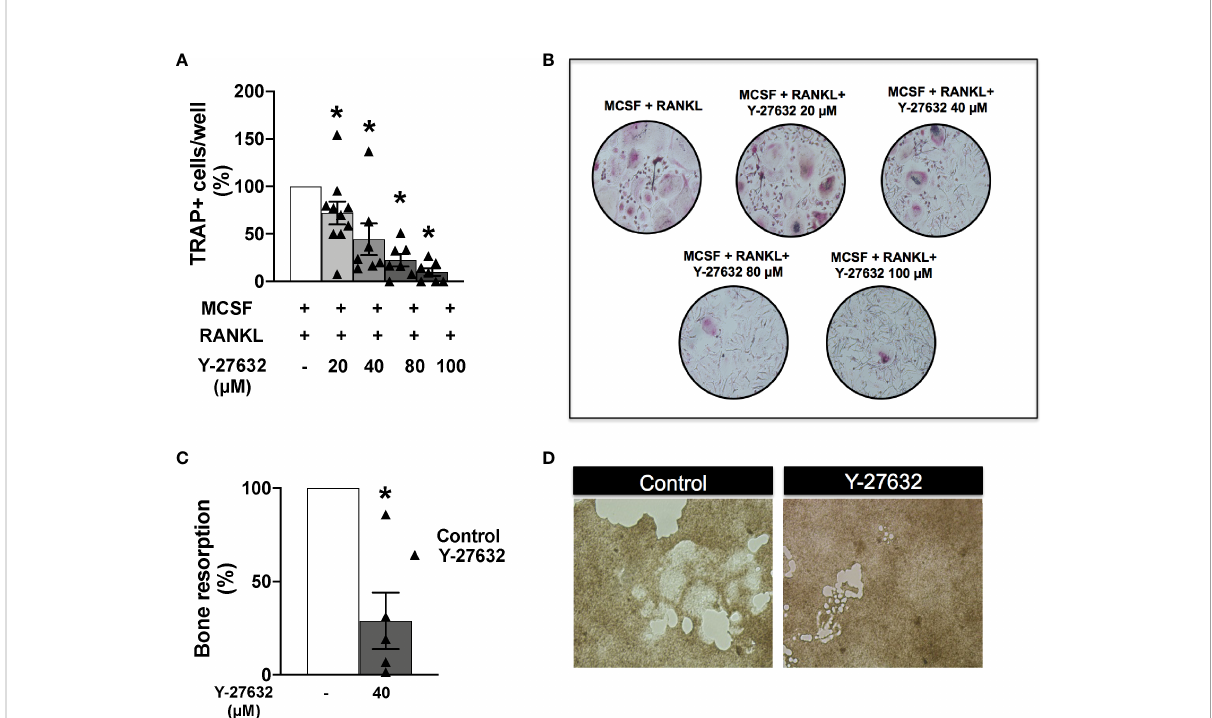
FIGURE 7 Inhibition of ROCK with Y-27632 also reduced osteoclast differentiation and bone resorption in cells from patients with in fl ammatory arthritis. (A) Percentage of TRAP+ multinucleated cells differentiated from blood monocytes of patients with in fl ammatory arthritis in the presence of MCSF and RANKL and the indicated concentrations of Y-27632. (B) Representative images of experiments in (A) . (C) Bone resorption area produced by differentiated osteoclasts from patients with in fl ammatory arthritis treated with 40µM Y-27632 relative to the same cells without Y-27632. (D) Representative pictures of the resorption pits in (C) Positive control (MCSF+RANKL) was considered 100%. Values are the Mean ± SEM of cells from 5-6 patients with in fl ammatory arthritis. *p < 0.05 (Wilcoxon